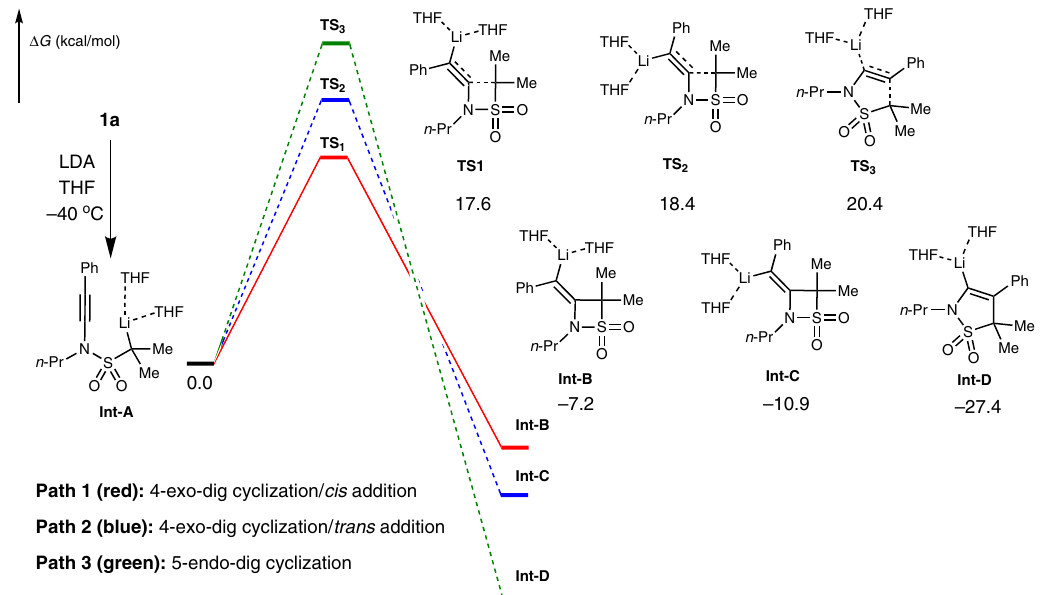
Fig. 7 DFT calculations for the LDA-mediated cyclization in the skeleton reorganization. Free energy pro fi les (kcal/mol) of three possible cyclizations from Int-A . path 1 (red): 4-exo-dig cyclization/ cis addition leading to Int-B (via TS 1 ), path 2 (blue): 4-exo-dig cyclization/ trans addition leading to Int-C